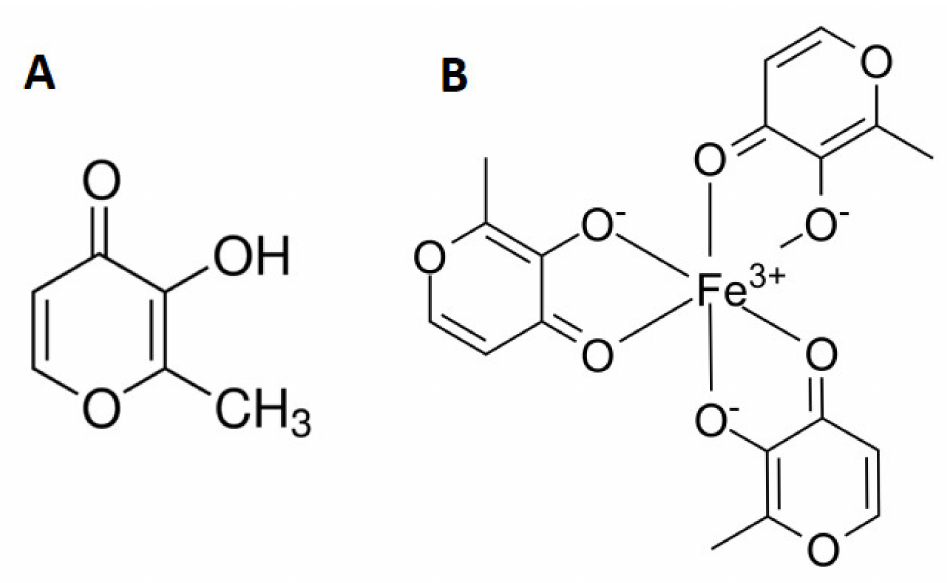
Figure 1. Molecular structure of ( A ) maltol and ( B ) ferric